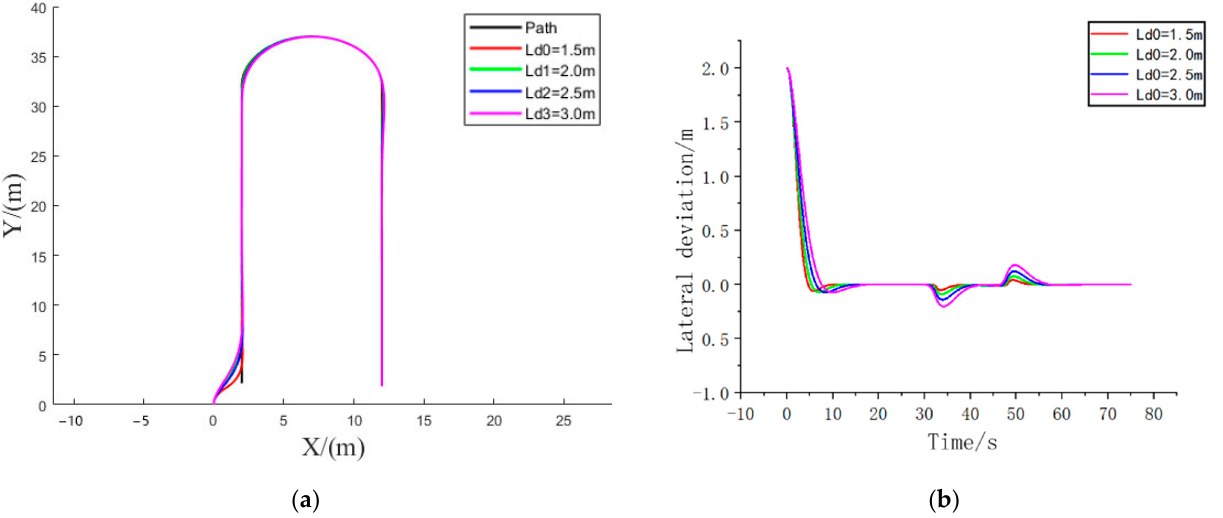
Figure 6. Traditional pure tracking algorithm path tracking. ( a ) Path tracking curve; ( b ) Lateral de- viation.